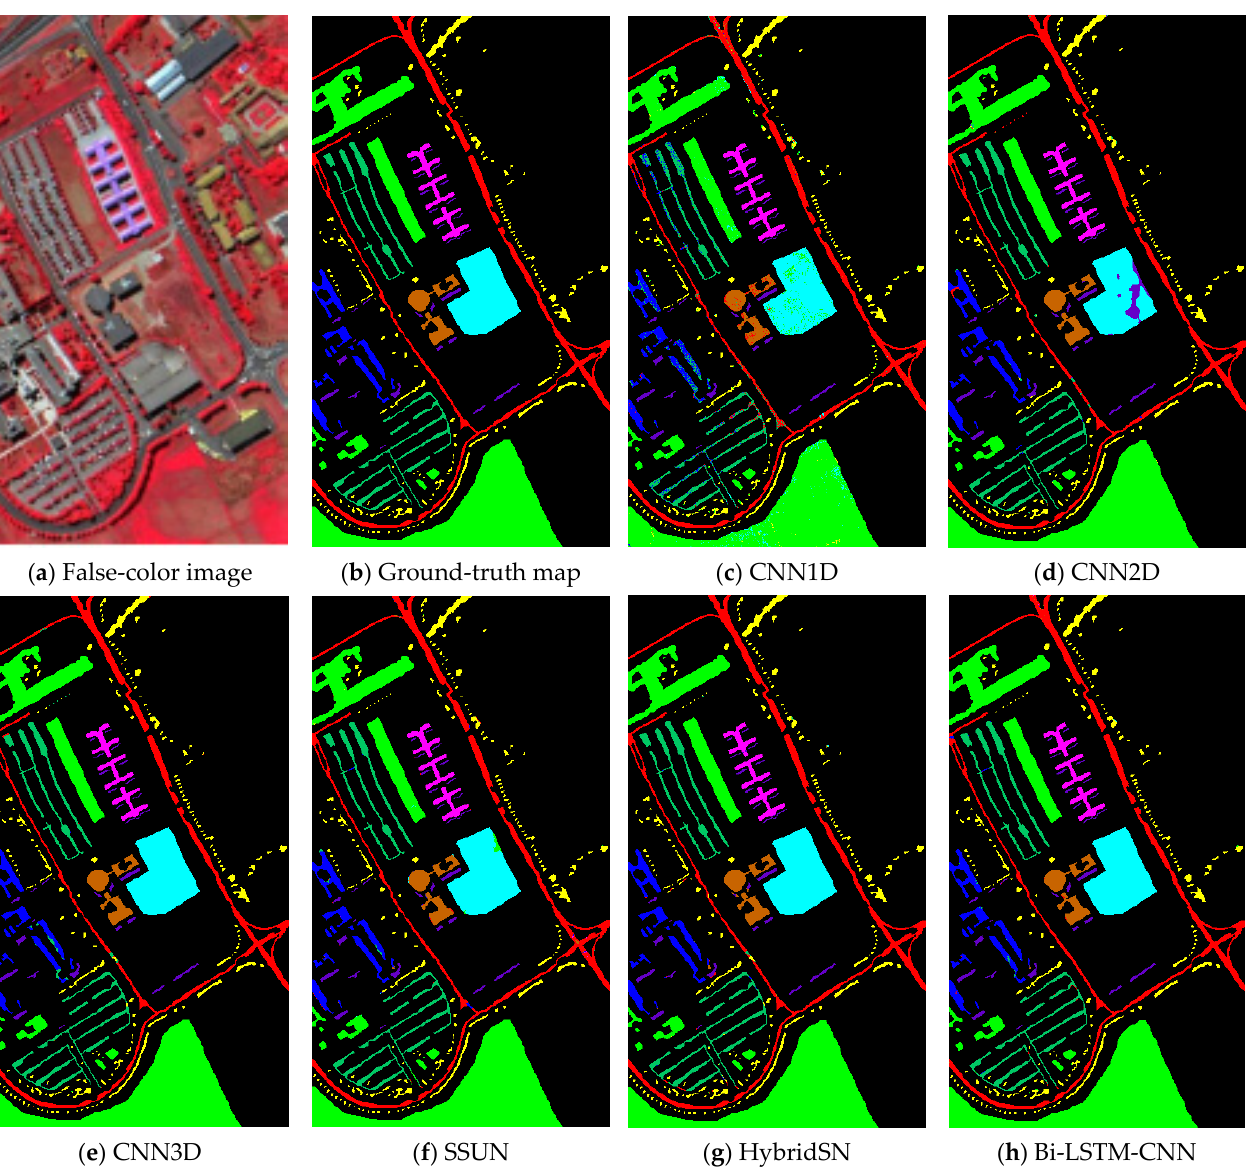
Figure 8. Classification maps for the PU dataset with 10% of training data. ( a ) False-color image; ( b ) Ground-truth map; ( c ) CNN1D; ( d ) CNN2D; ( e ) CNN3D; ( f ) SSUN; ( g ) HybridSN; ( h ) Bi-LSTM-CNN. Table 2. Details of the PU dataset.